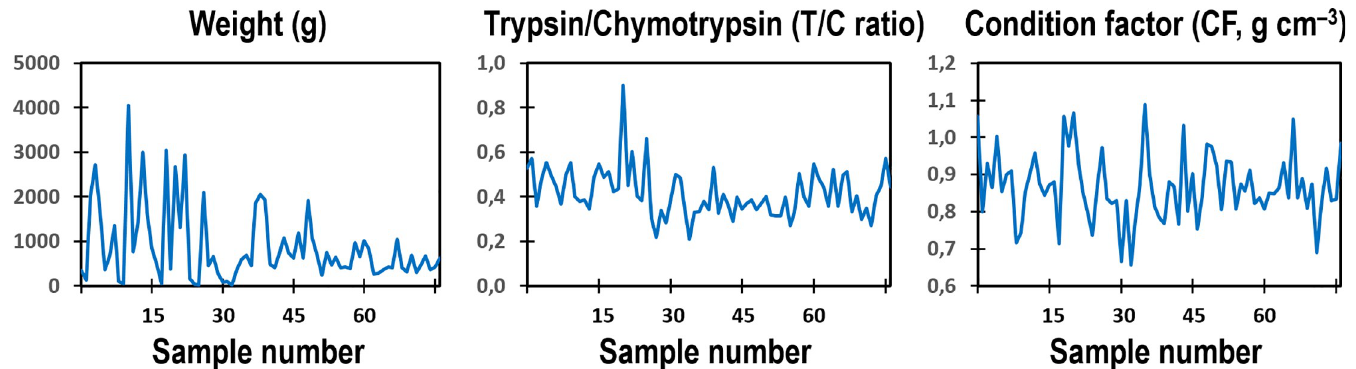
Fig 4. Dataset with weight, pyloric caecal T/C ratio, and CF of wild Northeast Arctic cod at adult stage during spawning migration. Weight, T/C ratio and CF values will be normalized to a range of between –1 and +1 for estimating individual SGR and testing our models. (original data from [12]).